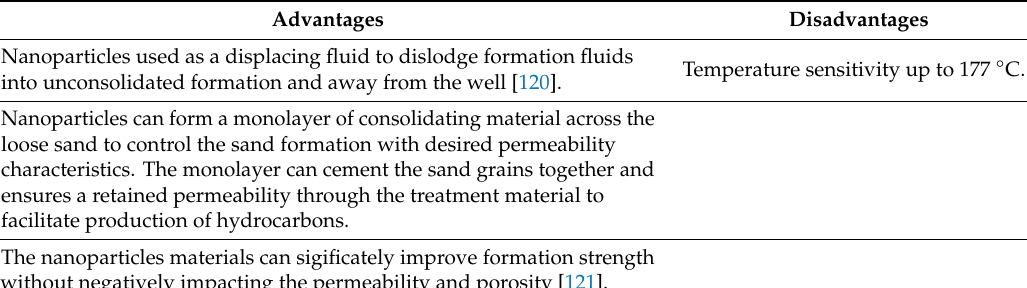
Table 26. Advantages and disadvantages of nanoparticles materials